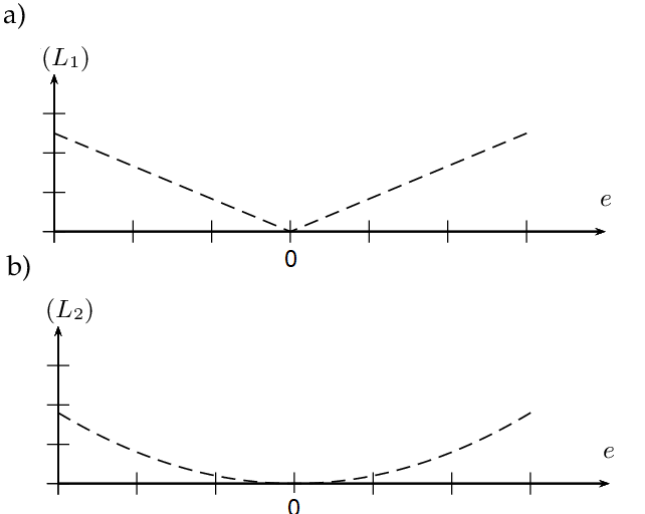
Figure 6. Penalty function plots vs. error, ( a ) L 1 , ( b ) L 2 penalty